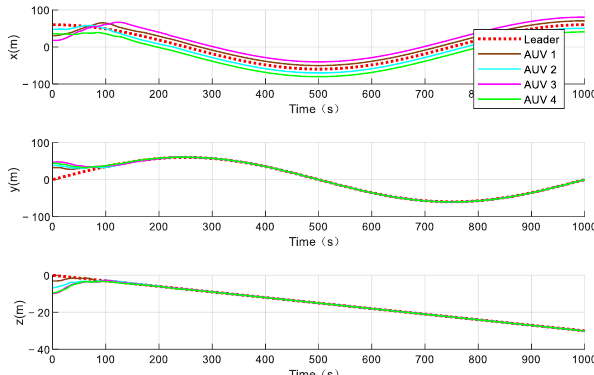
Figure 6. Position status of the AUV formation.